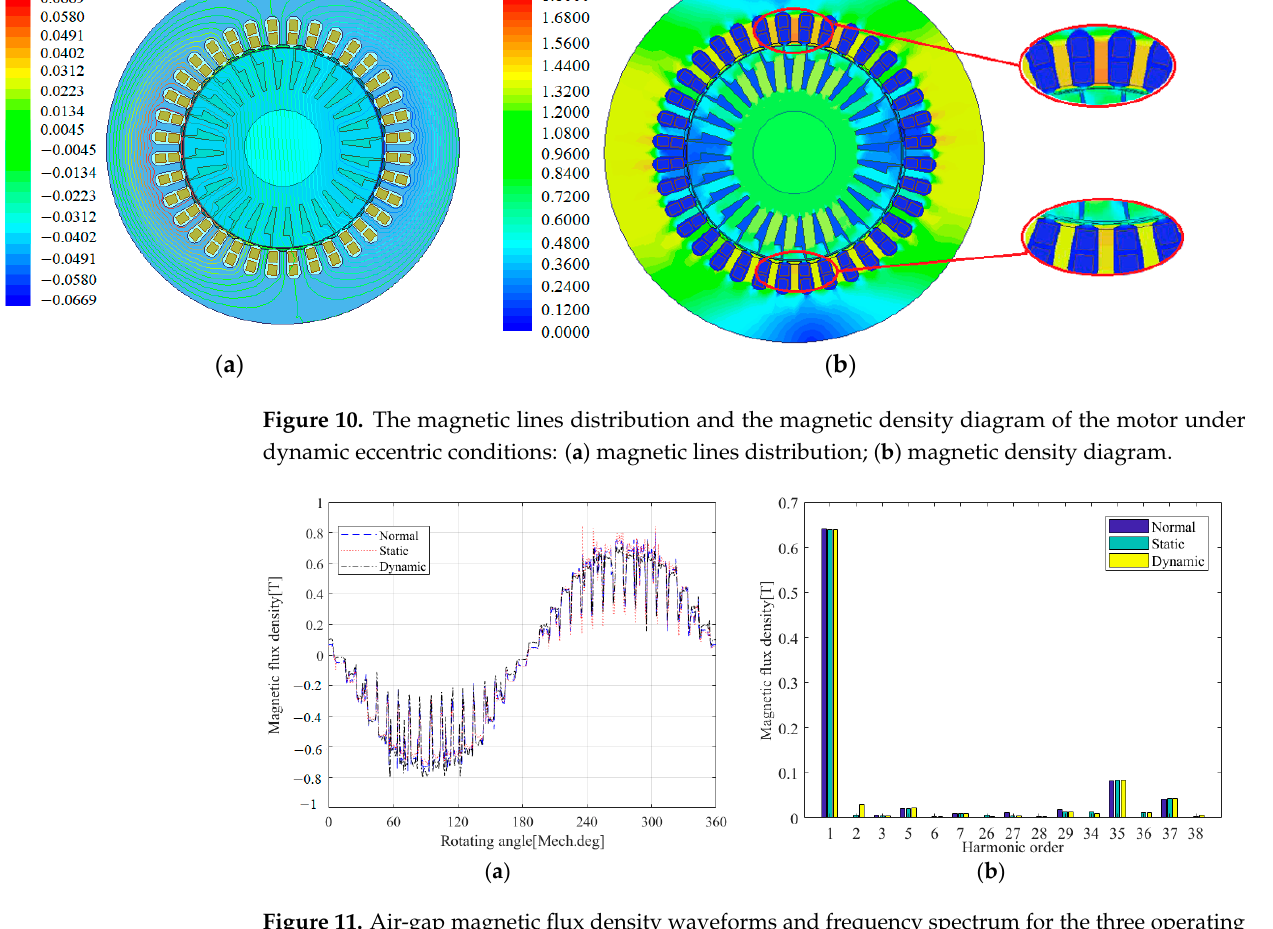
Figure 11. Air-gap magnetic flux density waveforms and frequency spectrum for the three operating conditions: ( a ) waveforms; ( b ) frequency spectrum. conditions: ( a ) waveforms; ( b ) frequency